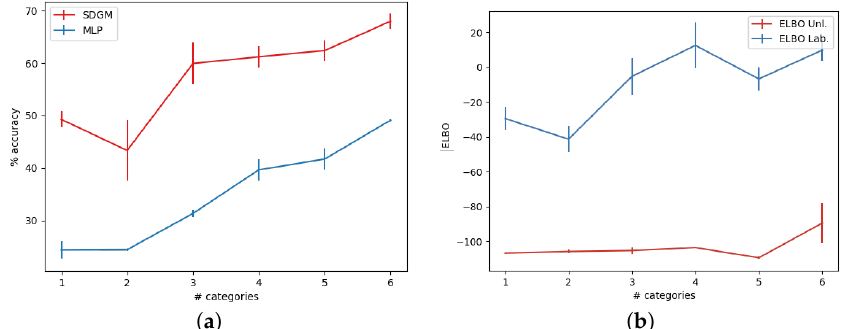
Figure 7. SDGMs and MLPs were trained with datasets from which we randomly subsampled a single data-point from each category and then progressively added 500 randomly labeled data points for each category, and we trained a new MLP and SDGM for each progression. ( a ) The accuracy of the classifiers for the SDGM and MLP. ( b ) The ELBO for the data categories included during training (ELBO Lab.) The data categories that are not included during training (ELBO Unl.). The categories that were progressively added followed the order of Table 1; i.e., first {PS7} , and next {PS7, RS4} , until reaching {PS7, RS4, PS50, RS8, PSRS, PS75} .